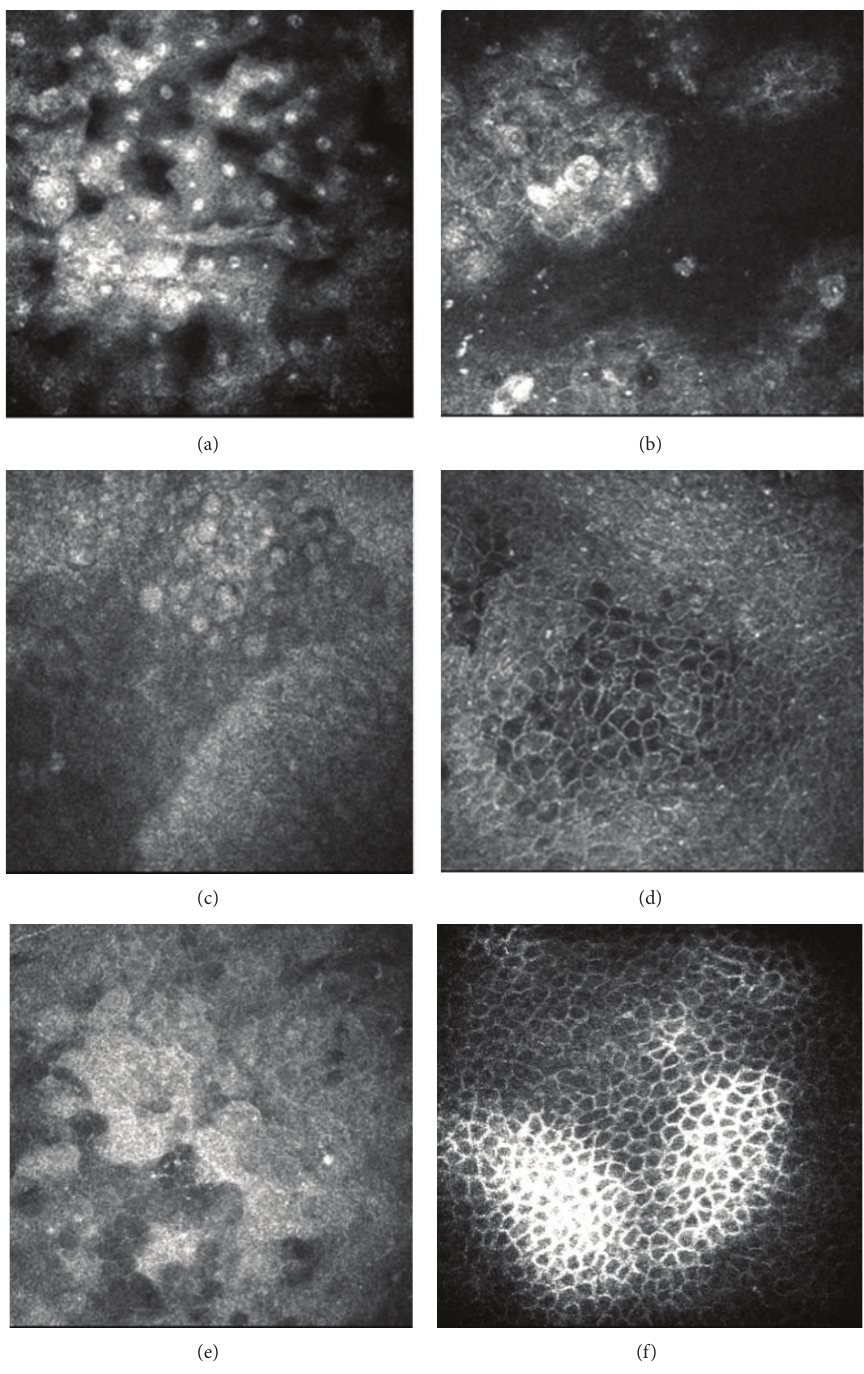
Figure 1: IVCM images of ocular surface in dry eye. (a) Squamous metaplasia of conjunctival epithelium. (b) Irregularity and desquamation of conjunctival epithelium. (c–f) Improving of quality and regularity of conjunctival epithelial cells more evident after 90 days of Optive treatment (c-d) with respect to Hylogel group